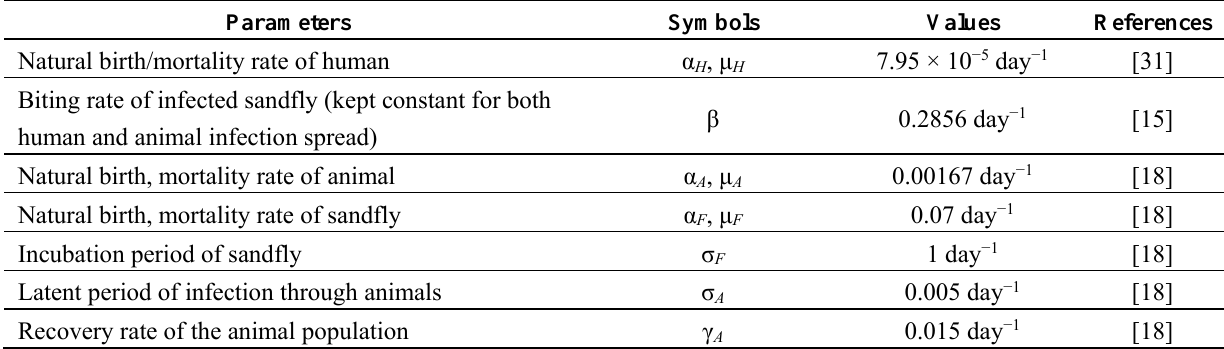
Table 1. Model parameters and their numeric values used for further